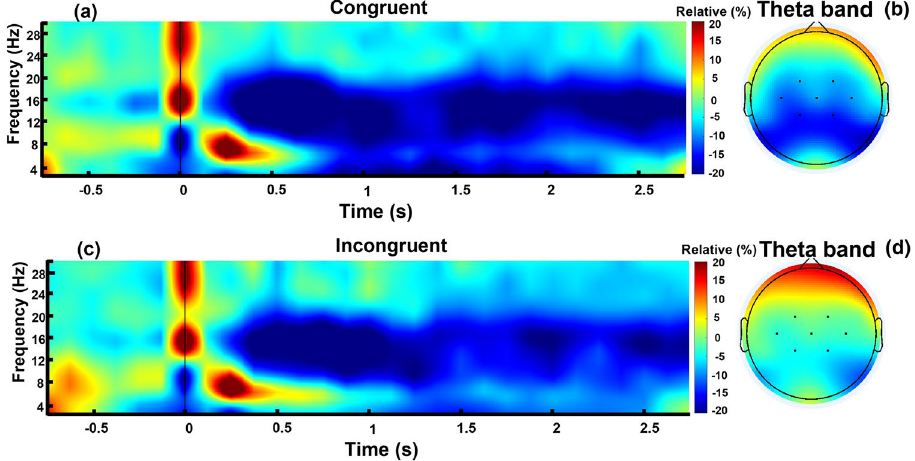
Figure 2. Time–frequency and topo-map (of theta band in central region) for congruent and incongruent conditions, calculated from brain activity of central region. Hot colors show positive relative power and cold colors show negative relative power. Panels ( a ) and ( c ) show time–frequency of congruent and incongruent conditions respectively. Both panels are plotted from − 0.75 to 2.75 s. The y-axis indicates frequency and the x-axis indicates time. The vertical black line in 0 s indicates the start of the stimuli. Panels ( b ) and ( d ) show topo-maps of brain activity in theta band of congruent and incongruent conditions respectively. The activity is averaged over theta (4 to 7 Hz) and time (0 to 2 s), and plotted as